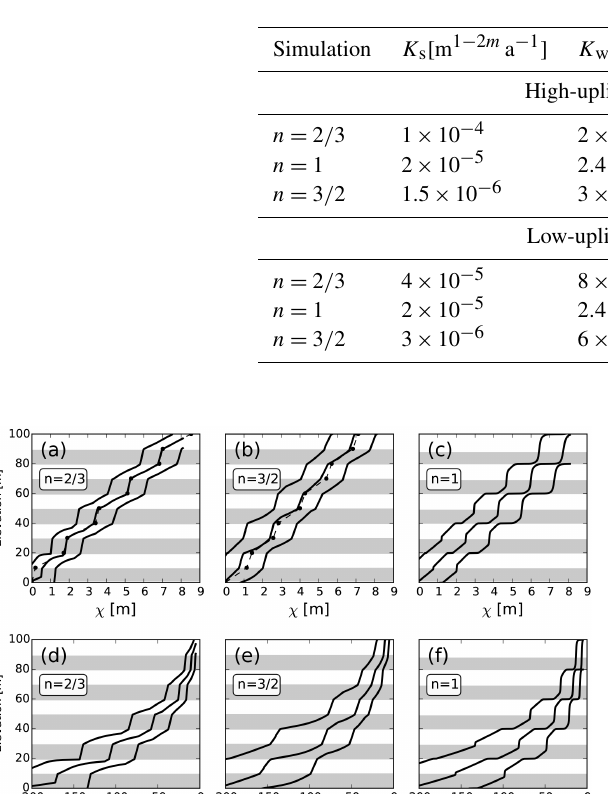
Table 1. Parameters used in the 1-D model runs.